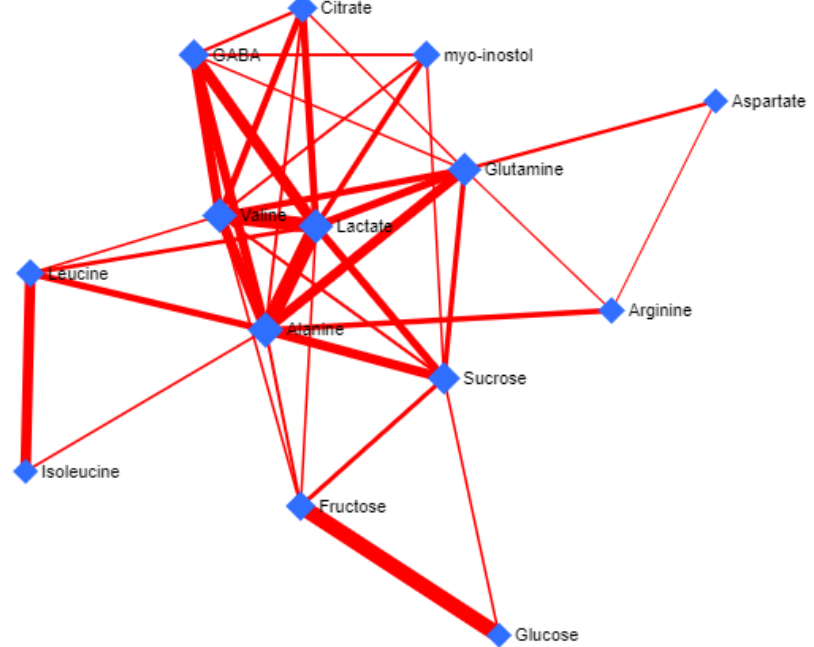
Figure 11. Partial correlation network of the metabolites identified in lemon juice. The size of the node indicates the direction of change. The colored borders have a p -value < 0.05 and the false discovery rate (FDR)-adjusted p -value < 0.2. The red borders show positive correlations. Out of the 34 metabolic pathways determined based on the results of the juice DSPC analysis, 3 were found to be significant (Impact > 0.2). Similar to the lemon peel samples, the metabolism of alanine, aspartate, and glutamate had the highest number of